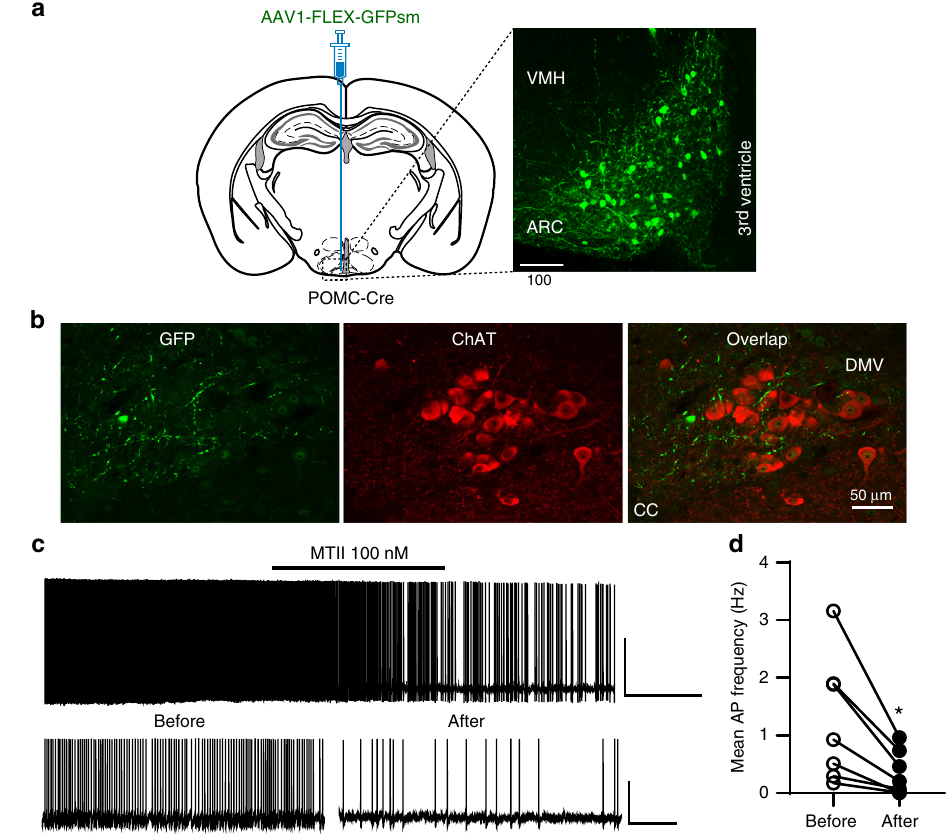
Fig. 1 DMV cholinergic neurons receive POMC input from the ARC. a Schematic diagram of the experimental con fi guration. AAV1-FLEX-GFPsm viruses were injected into the ARC of POMC-Cre mice (left panel). Expression of GFP-positive cells was clearly visible in in the ARC (right panel). Scale bar: 100 µ m. VMH ventromedial hypothalamus. b Images of confocal fl uorescence microscopy showing double immunostaining with anti-GFP (green, left panel) and anti-ChAT (red, middle panel) antibodies. GFP-positive fi bers were visible in the DMV (right panel), representing DMV cholinergic neurons received POMC input from the ARC. Scale bar: 50 µ m. CC central canal. c , d Representative traces showing reduced DMV cholinergic neuron activity in response to treatment with MTII (100 nM) in the absence of synaptic blockers ( c ). Plots showing individual data as to mean frequency of action potentials before and after treatment with MTII ( d ) (mean frequency: 1.3 ± 0.3 Hz vs. 0.3 ± 0.1 Hz, n = 7 out of ten neurons, two-tailed t test, * p = 0.02; V m : − 45.6 ± 1.8 mV vs. − 45.8 ± 2.2 mV, two-tailed t test, p = 0.9). All data are shown as mean ± SEM. Source data are provided as a Source Data fi